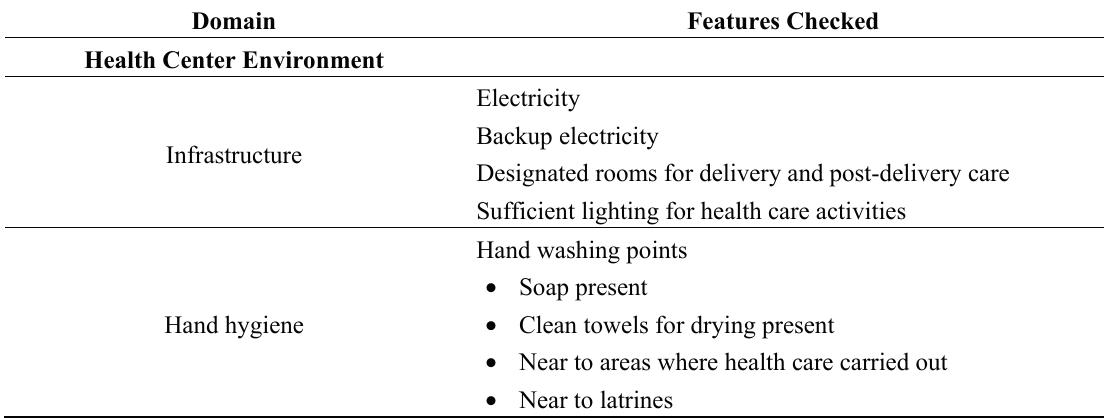
Table 2. Structured observation checklist items for the health center and home